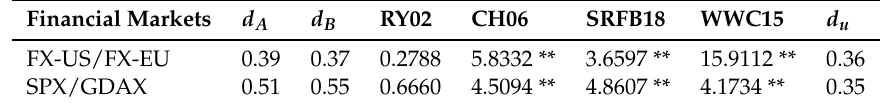
Table 11. Results for stationary fractional cointegration for the subsample 04/11/2008-29/12/2016.